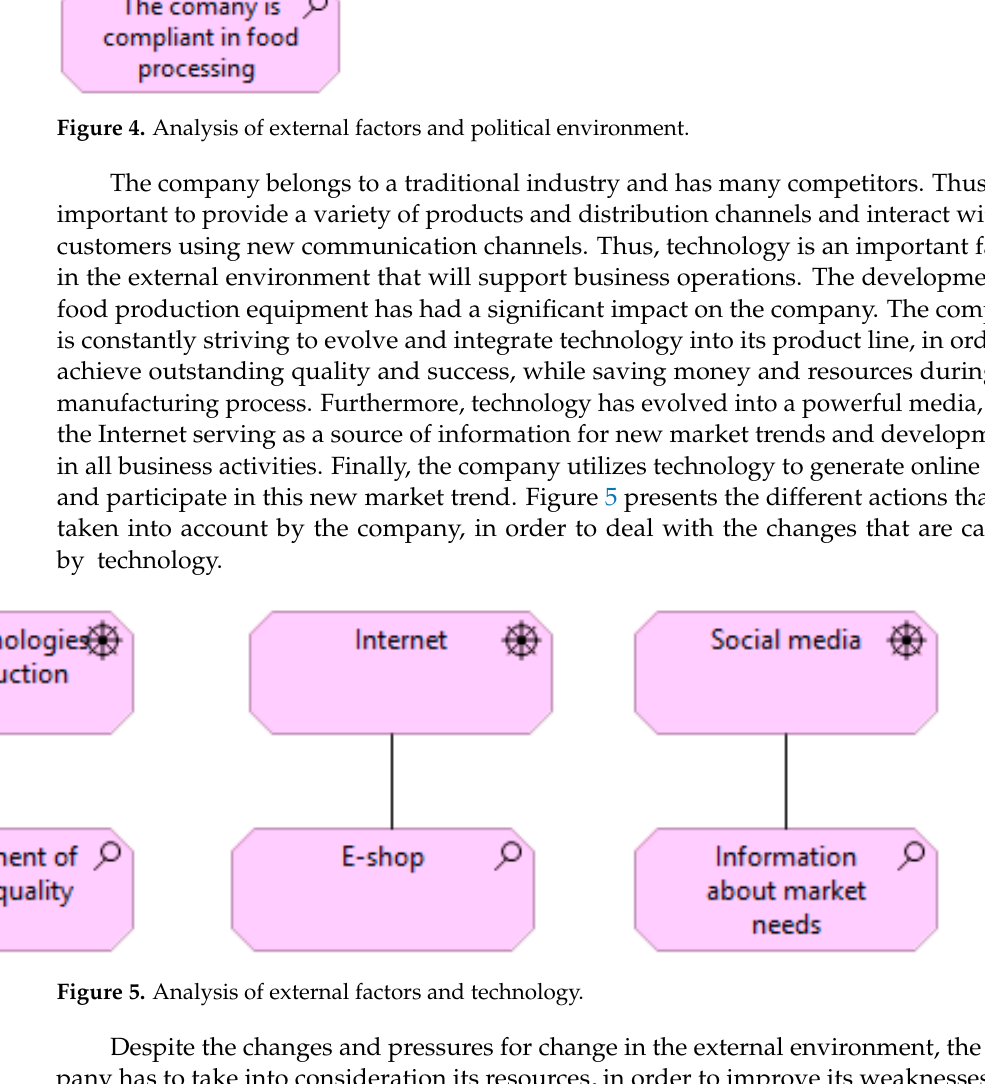
Figure 6. Link between capabilities and external factors. Another difficulty concerns how the products are distributed nationwide, such as the construction of a product distribution network, because the company is called upon to find many partners, logistics companies, and representatives. Finding new partners, in particular, entails a high margin of risk because the company cannot guarantee immediate and timely payment. As a result, in these areas, the company cannot ensure the high qual- ity of distribution and customer service. As a result, when the company is called upon to expand its network in many areas, it becomes a significant challenge. To address this chal- lenge, namely network development, choose partners already familiar with the company to increase the chances of a successful collaboration. Figure 7 presents the link between capabilities and external factors. Figure 7. The link between capabilities and external factors. Finally, another challenge is the existence of marketing by competing companies, as they have existed in the field for several years and, thus, have strengthened their network and brand name towards the consumer. This weakness is addressed through the invest- ment in upgrading the company’s brand name because over 50% of the company’s profits are invested in the development of the network and strengthening of its name. More spe- cifically, to strengthen its name, the company sells products not only in various places but